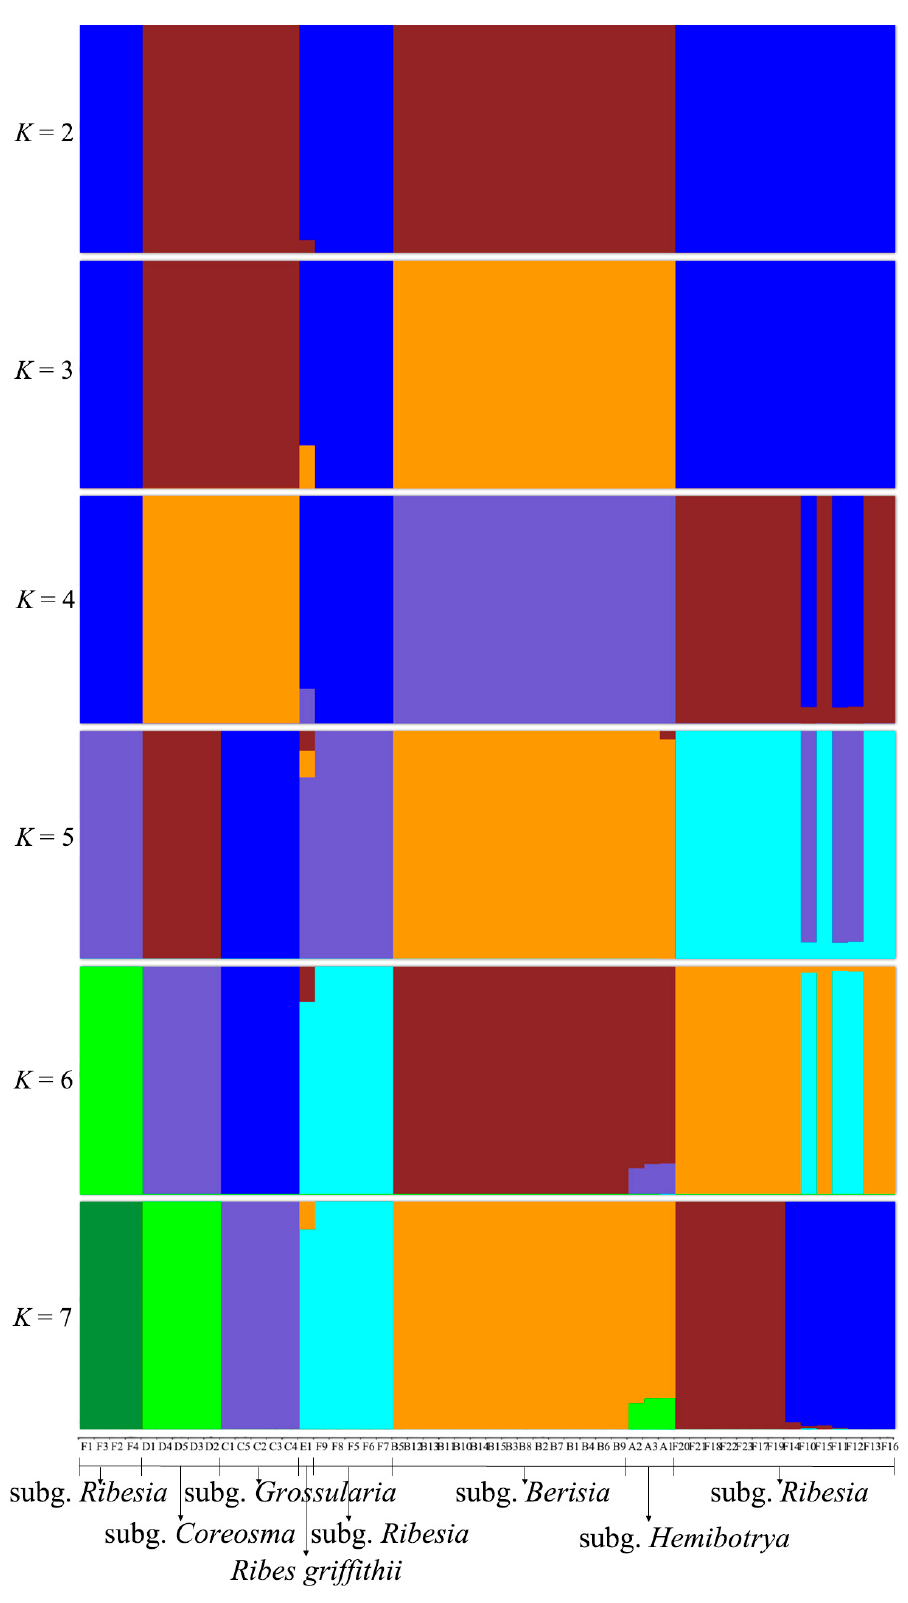
Figure 3. The genetic structure of 52 Ribes L. samples. Different ancestral populations are distin- guished by different colors. Each individual is a column of histograms in the figure, and the difference in color is used to indicate the ancestral composition of different individuals.